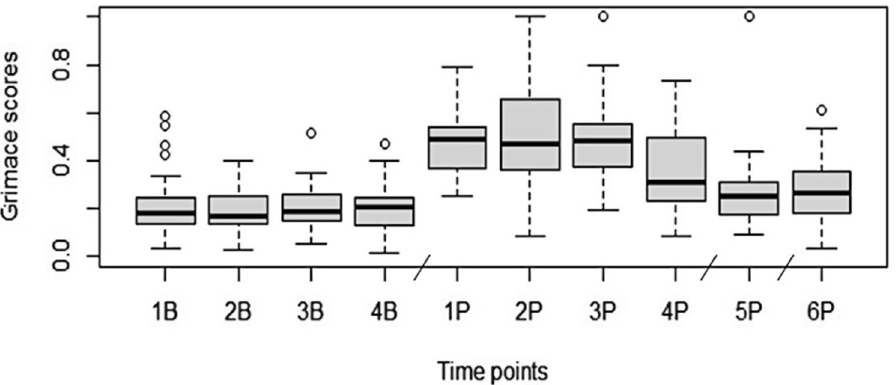
Figure 3. The Cynomolgus Macaque Grimace Scale. Included are descriptions of each action unit, including three facial action units: orbital tightening, brow lowering, and lip tightening, and one postural measure: hunched posture. Each action unit was scored on a 3-point scale based on whether it is not present (score of 0), moderately present (score of 1), or present (score of 2) except lip tightening, which was scored on a 2-point scale based on absence (score of 0) or presence (score of